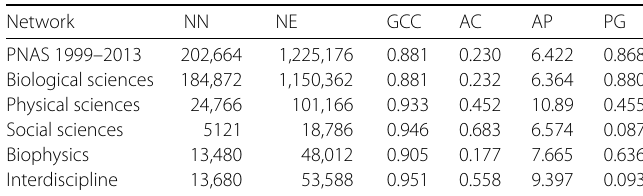
Table 3 Specific statistical indexes of the analyzed networks Network NN NE